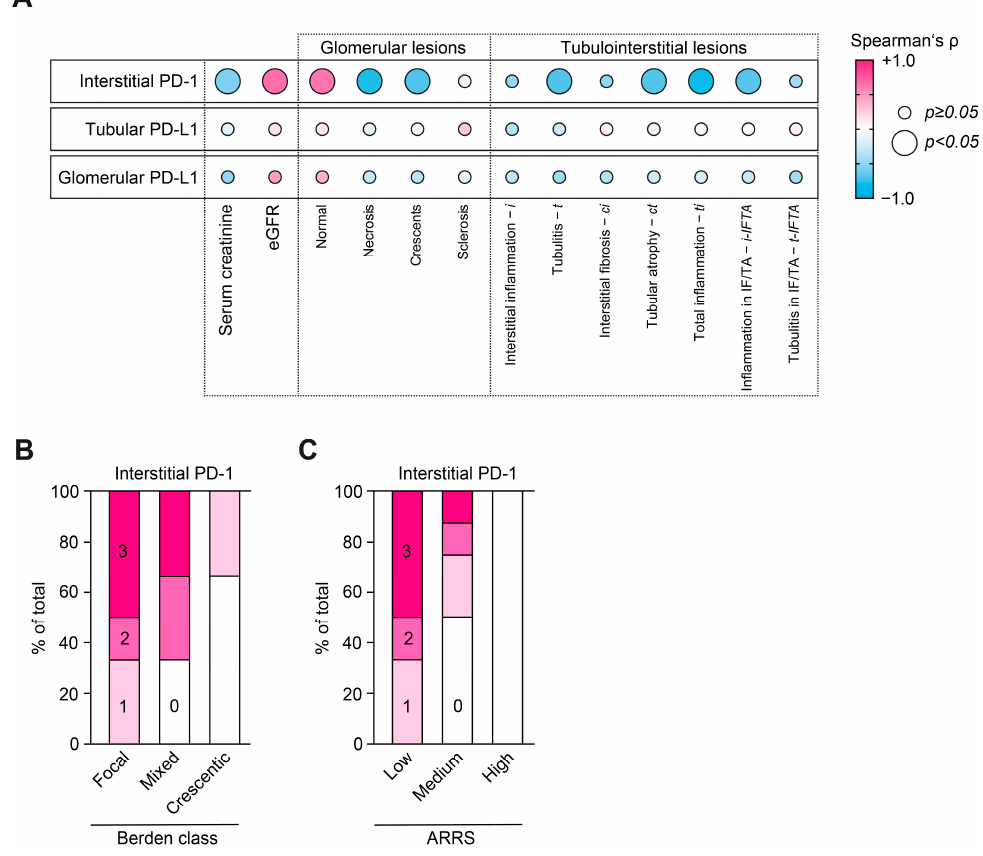
Figure 2. Loss of interstitial PD-1 correlates with active ANCA-associated renal vasculitis. ( A ) Correlations between PD-1 and PD-L1 positivity, markers of kidney injury and histopathological lesions in ANCA-associated renal vasculitis (n = 15) are shown by heatmap reflecting mean values of Spearman’s ρ ; circle size represents significance level. ( B , C ) Quantification of interstitial PD-1 is shown as fraction of total according to Berden classification and ARRS.